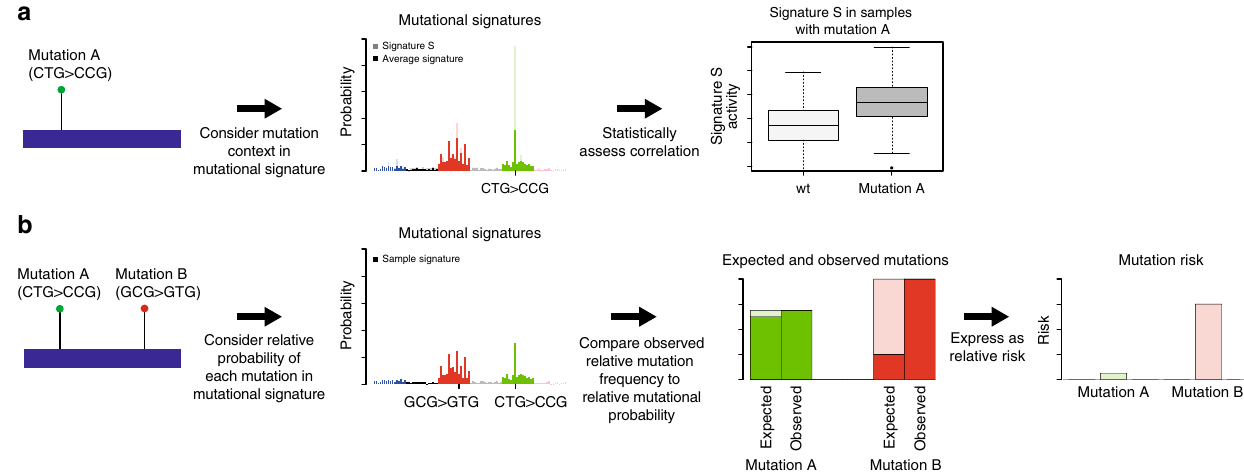
Fig. 1 Schematic representation of the approach. a In the fi rst part of the study, the effects of mutational process activity on driver mutation frequencies were investigated. For a driver mutation, the change was assigned to one of the 96 trinucleotide mutational channels (e.g., CTG > CCG). We hypothesised that mutational signatures in which that channel was higher than average would be over-represented in cancers with these mutations. We tested this hypothesis by comparing the levels of signatures in cancers harbouring the mutations to those in cancers that did not harbour the mutations. b In the second part of the study, we investigated the effects of mutational processes on the relative frequencies of speci fi c pathogenic mutations in cancer driver genes. The causal channels of the different driver mutations (different amino-acid changes) within a gene were identi fi ed on a tumour type by tumour type basis. We then tested whether observed frequencies of each driver mutation differed signi fi cantly from those expected based on mutational process activity alone, thus indicating differential selection between mutations in the same gene. Using a simple mathematical model, we transformed normalised measurements of mutation frequency into estimates of relative risk between mutations. This analysis was then extended to comparisons between mutations in different driver genes with apparently equivalent functional effects in a cancer